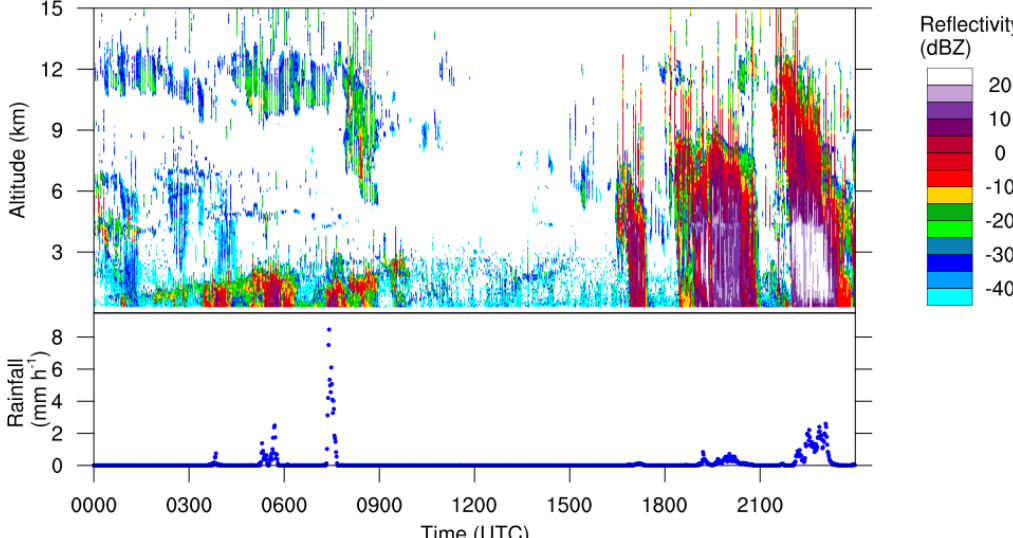
Figure 5. Time evolution of ( top ) the reflectivity in the atmospheric column above Savè retrieved by the cloud radar and ( bottom ) the rain rate derived from a